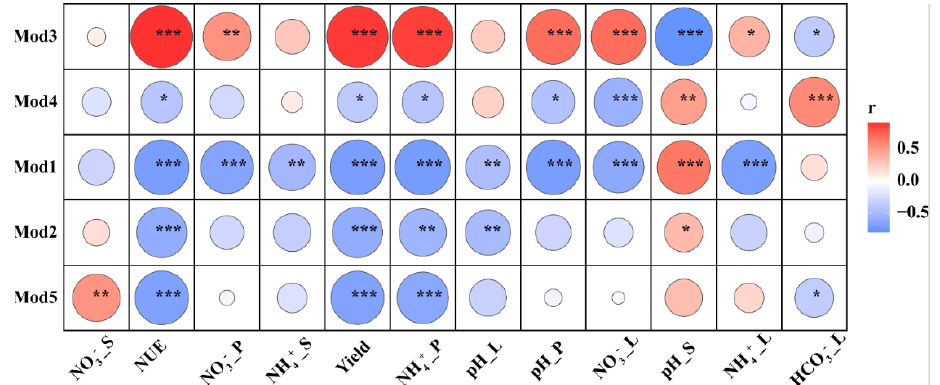
Figure 6. Pearson correlation heat maps of environmental factors and the five modules. Red repre- sents a positive correlation, and blue represents a negative correlation (* p < 0.05; ** p < 0.01; *** p <